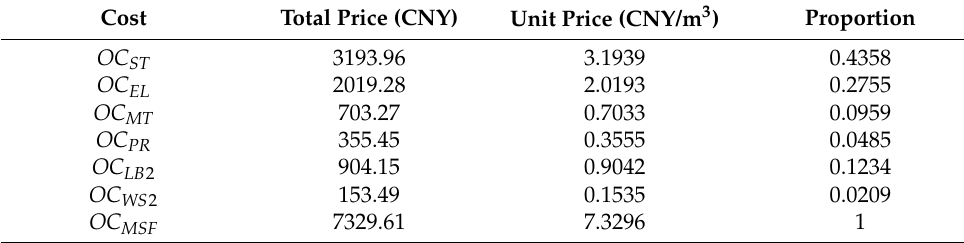
Table 12. BR-MSF system cost ratio table.